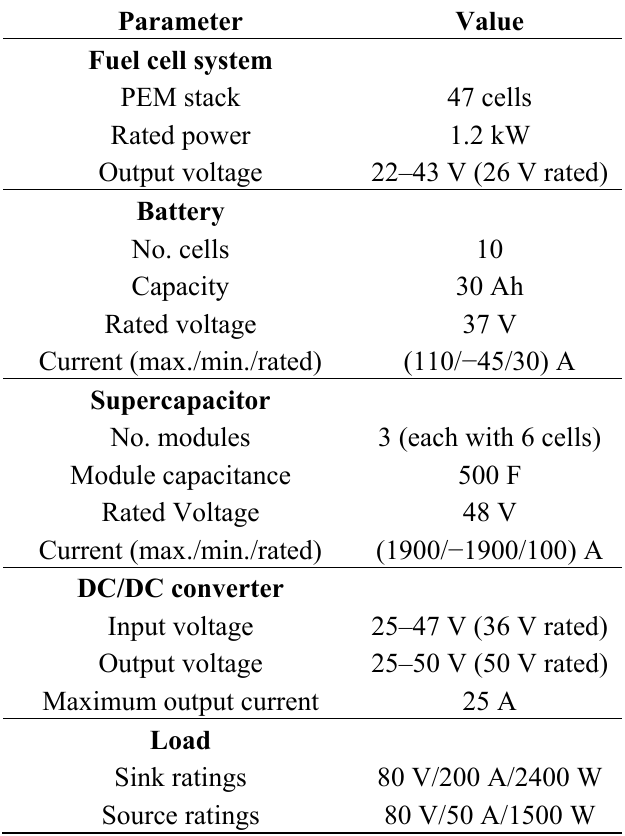
Figure 3. Photograph of the Hardware-in-the-Loop test bench. Table 1. Specifications of the test